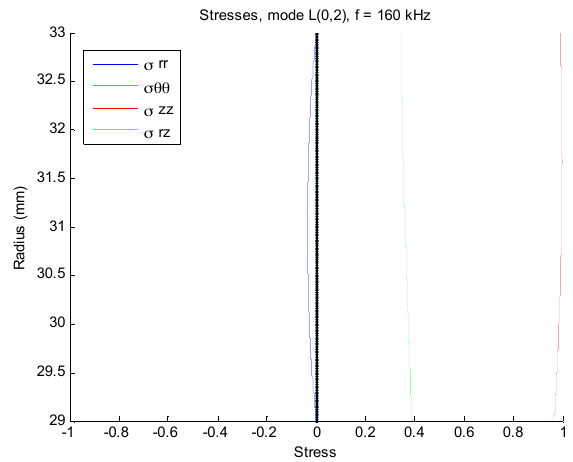
Figure 5. Stress field of L(0,2) mode at 160 kHz in a steel pipe.